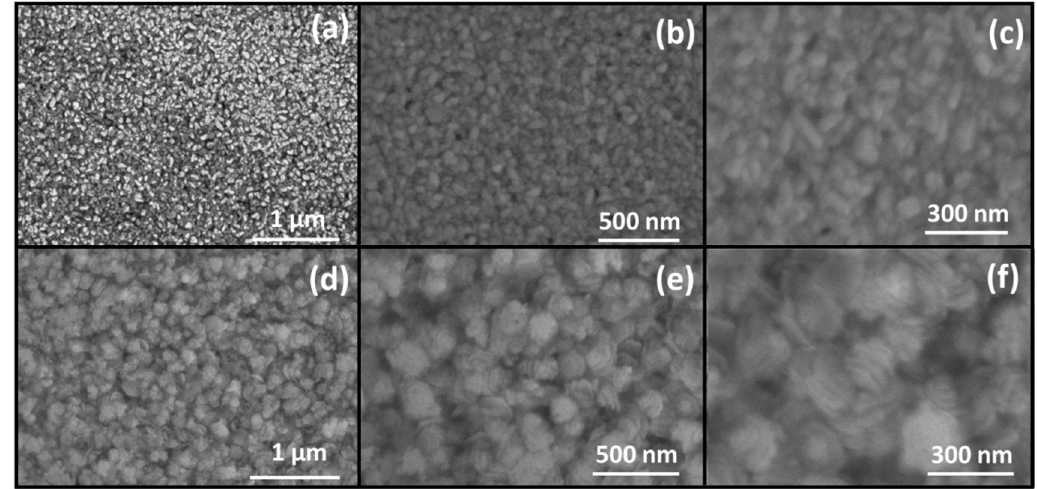
Figure 4. SEM micrographs of ZnO and ZnO-rGO_3 films at di ff erent scale (1 µ m, 500 nm and 300 nm). ( a–c ) ZnO and ( d–f ) ZnO-rGO_3.